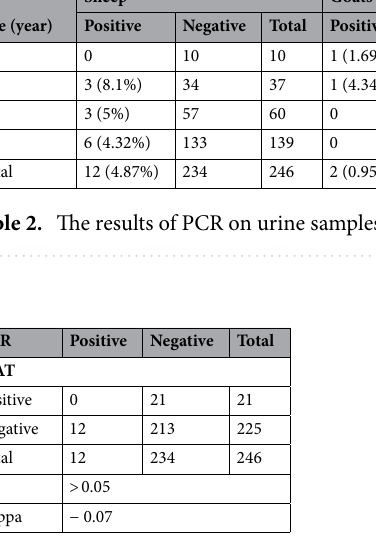
Table 3. Relationship between the results of MAT and PCR in sheep.